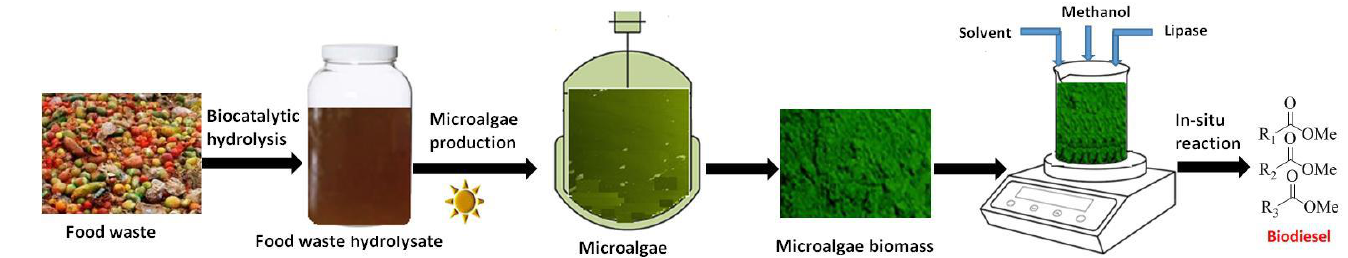
Figure 12. Cultivation of microalgae in food waste hydrolysate followed by insitu reaction of resulting microbial biomass with methanol to yield biodiesel.